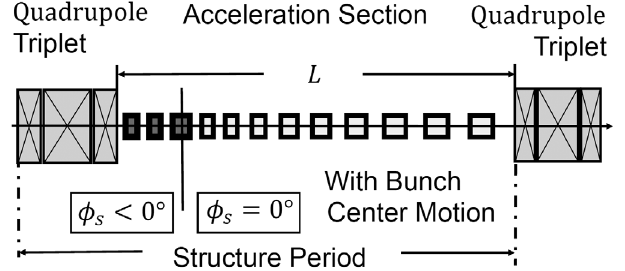
FIG. 2. Scheme of a KONUS lattice period: Transverse focus- ing is obtained by quadrupole lenses (here FDF-O-FDF-O lattice); longitudinal focusing and acceleration are achieved by a rebunching section at constant negative synchronous phase, followed by a zero degree section with the bunch injected at a slightly higher energy.